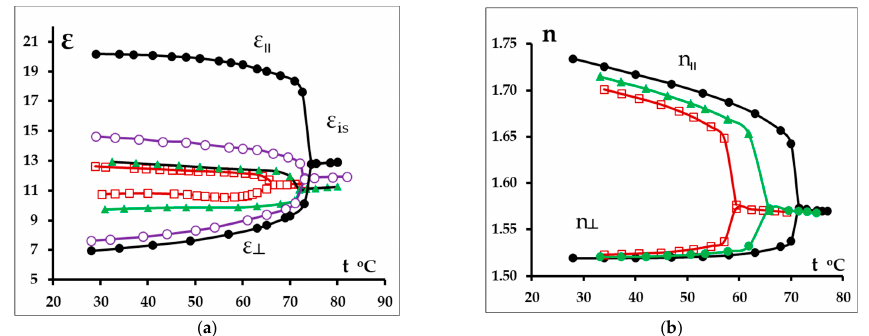
Figure 6. The effect of temperature and dopant concentration on the components of dielectric per- mittivity ( a ) and birefringence ( b )of CPDA solutions in CB-2. ( ● —CB-2; ○ —0.712%; ▲ —1.107%; □ -